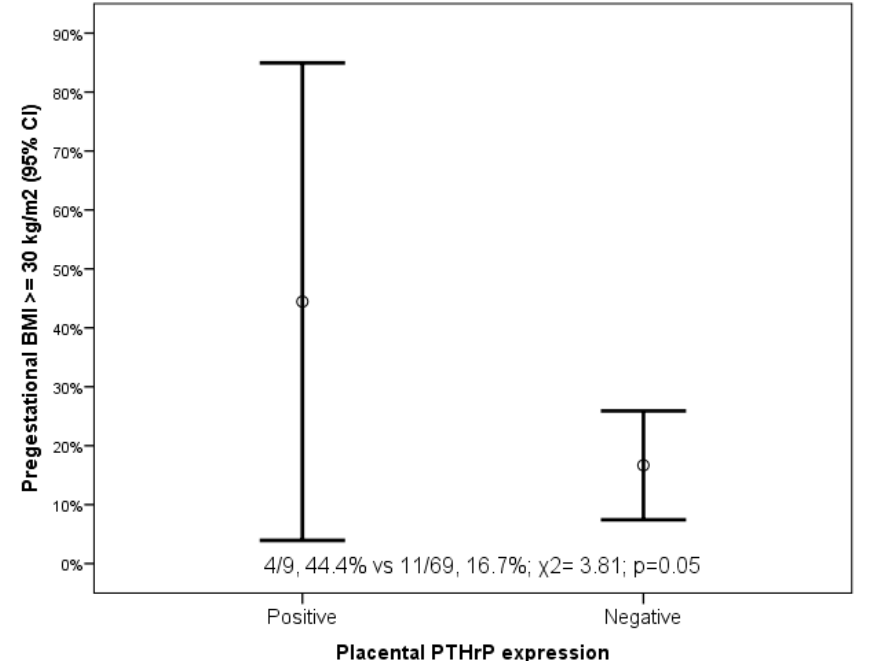
Figure 4. PTH-rP expression in syncytiotrophoblast in women with gestational diabetes according to maternal pregestational body mass index (BMI).